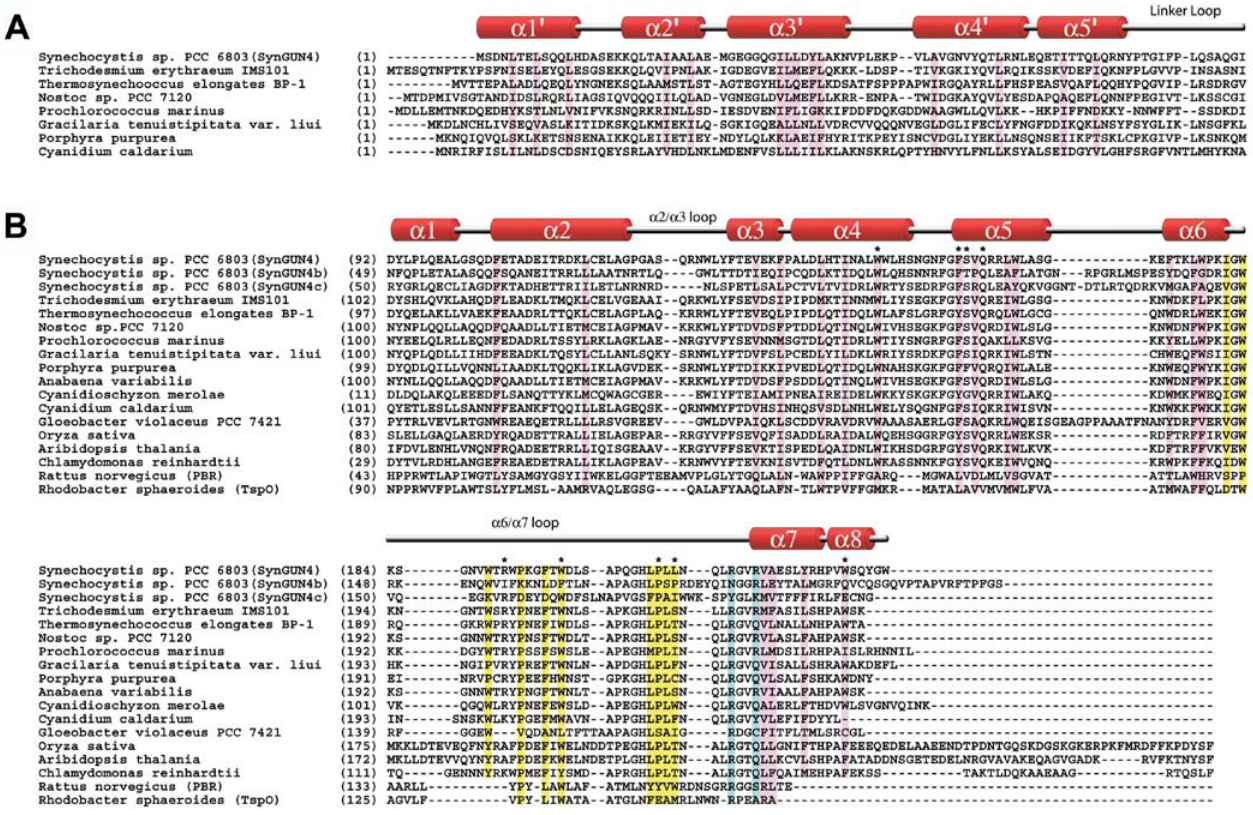
Figure 2. Sequence Alignment of GUN4 and GUN4-like Proteins (A) Alignment of the N-terminal portions of GUN4 family members whose N-terminal domains show sequence homology to SynGUN4. Residues contributing to the hydrophobic core of the five-helix bundle are highlighted (pink). GUN4 sequences isolated from plants thus far all have a plastid transit peptide in place of the N-terminal domain found in SynGUN4. The Chlamydomonas reinhardtii sequence was derived from sequence data produced by the United States Department of Energy Joint Genome Institute (http://www.jgi.doe.gov/). The N-terminal sequence of C. reinhardtii is not yet known but it most likely contains a chloroplast transit peptide. (B) Sequence alignment of possible GUN4 core domains. Residues that form the ‘‘ palm ’’ of the ‘‘ cupped hand ’’ are highlighted in pink. Residues from the a 6/ a 7 loop that structure the loop and protrude into the core are highlighted in yellow. Arg214 and Arg217, predicted to be important for binding to porphyrins, are highlighted in blue. Residues that disrupt proper folding when mutated and expressed in E. coli are denoted by an asterisk (*). DOI: